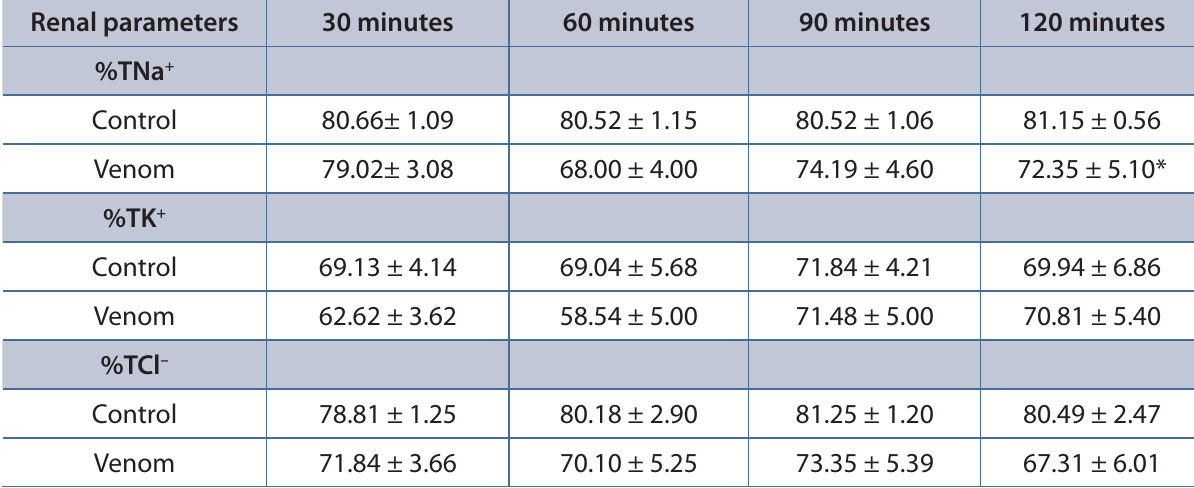
Table1. Effects of Polybia paulista venom (3 µg/mL) on electrolytes transport in isolated kidney Renal parameters